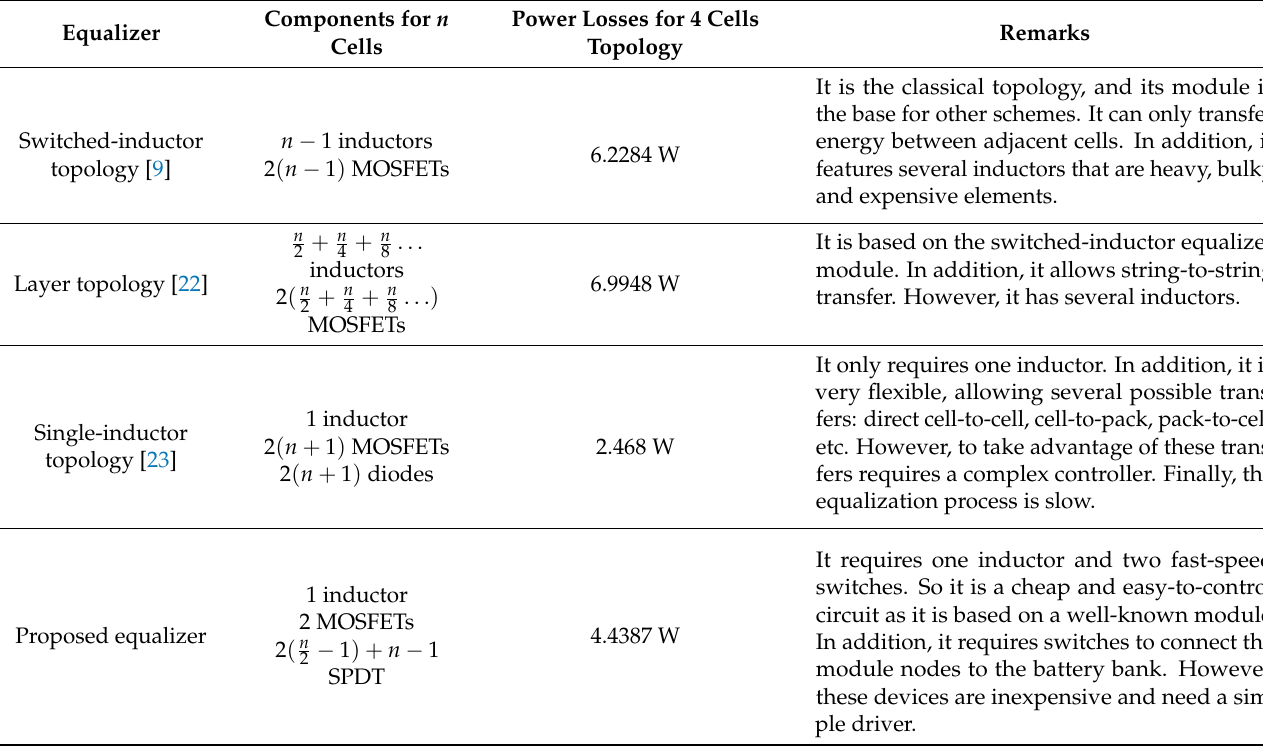
Table 2. Comparative analysis of the inductor-based BECs.